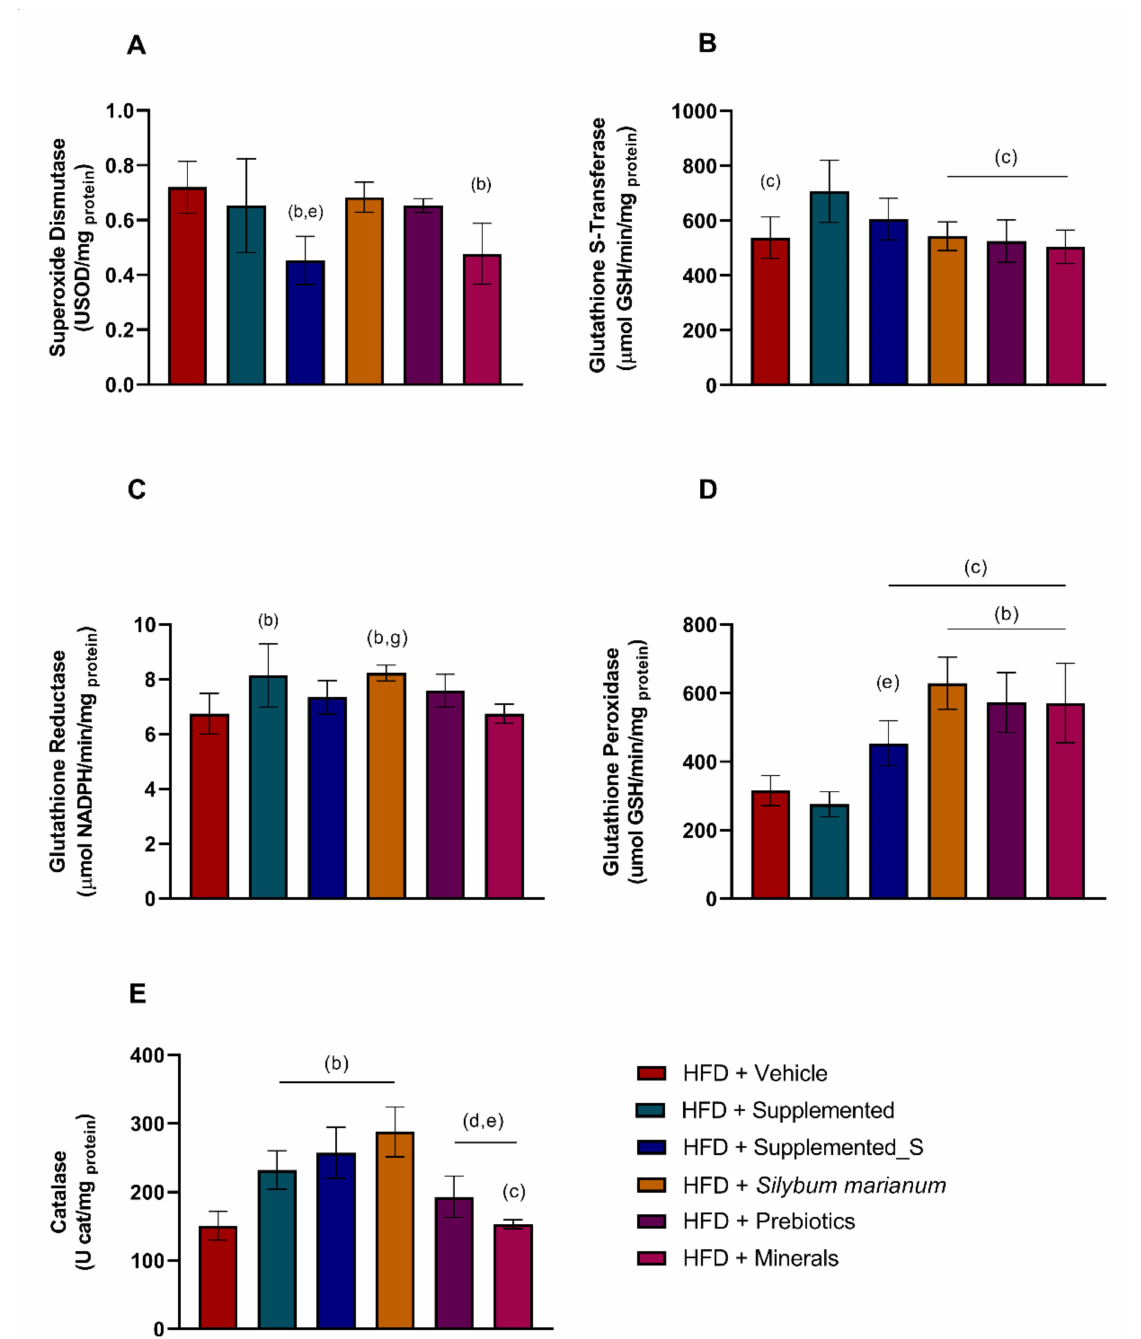
Figure 6. Antioxidant enzymes’ activity in liver samples. ( A ) SOD: superoxide dismutase; ( B ) GST: glutathione S-transferase; ( C ) GR: glutathione reductase; ( D ) GPX: glutathione peroxidase; ( E ) CAT: catalase. Significant p < 0.05 in one-way ANOVA followed by Tukey’s post-hoc test (n = 4–8 per group): (b) versus HFD + Vehicle (c) versus HFD + Supplemented; (d) versus HFD + Supplemented_S (e) versus HFD + Silybum marianum ; and (g) versus HFD + Minerals. HFD = high-fat diet. Values are means ±